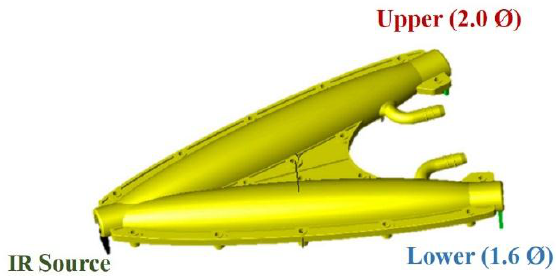
Figure 2. 3-D modeling of the sensor module.